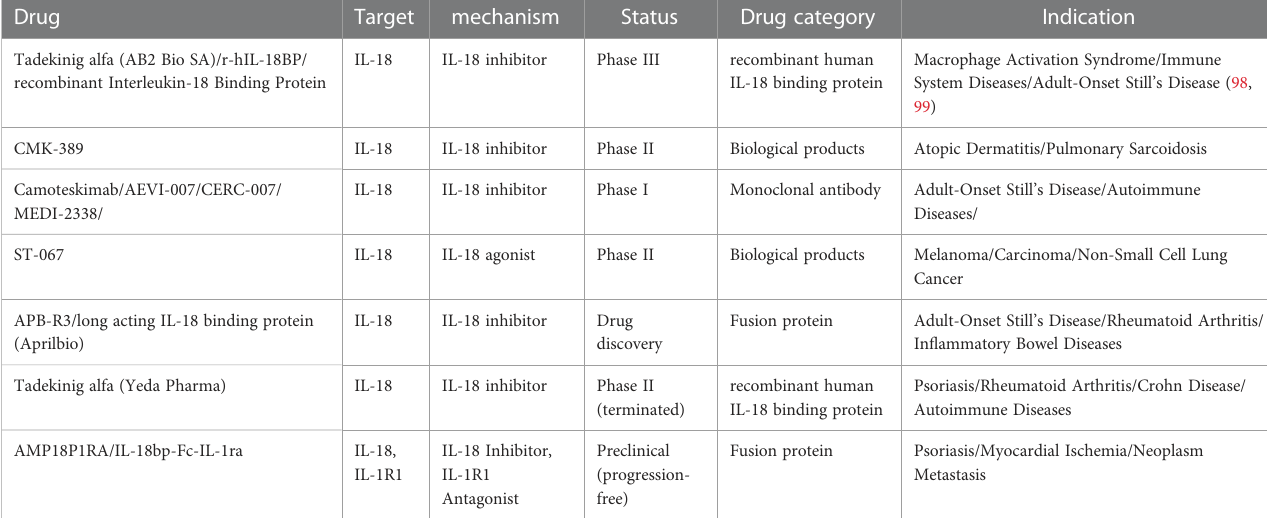
TABLE 1 Drugs targeting IL-18 and IL-18BP for in fl ammatory dermatological diseases and related